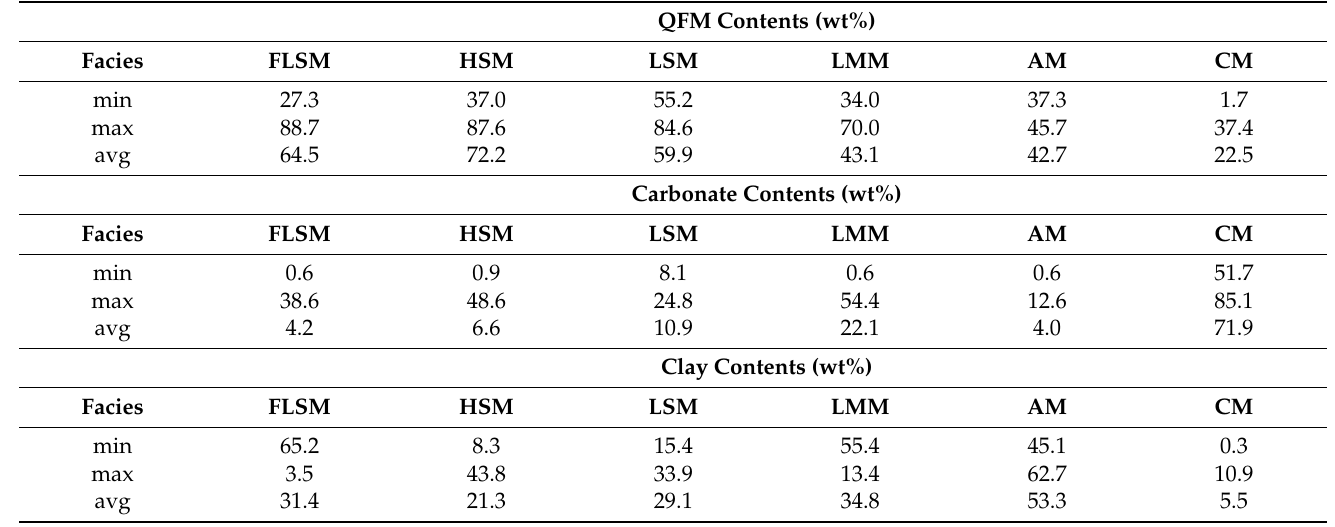
Table 1. Mineralogical compositions of the six core facies. FLSM: faintly laminated siliceous mudstone. HSM: homogeneous laminated siliceous mudstone. LSM: laminated siliceous mudstone. LMM: laminated mixed mudstone. AM: argillaceous mudstone. CM: calcareous